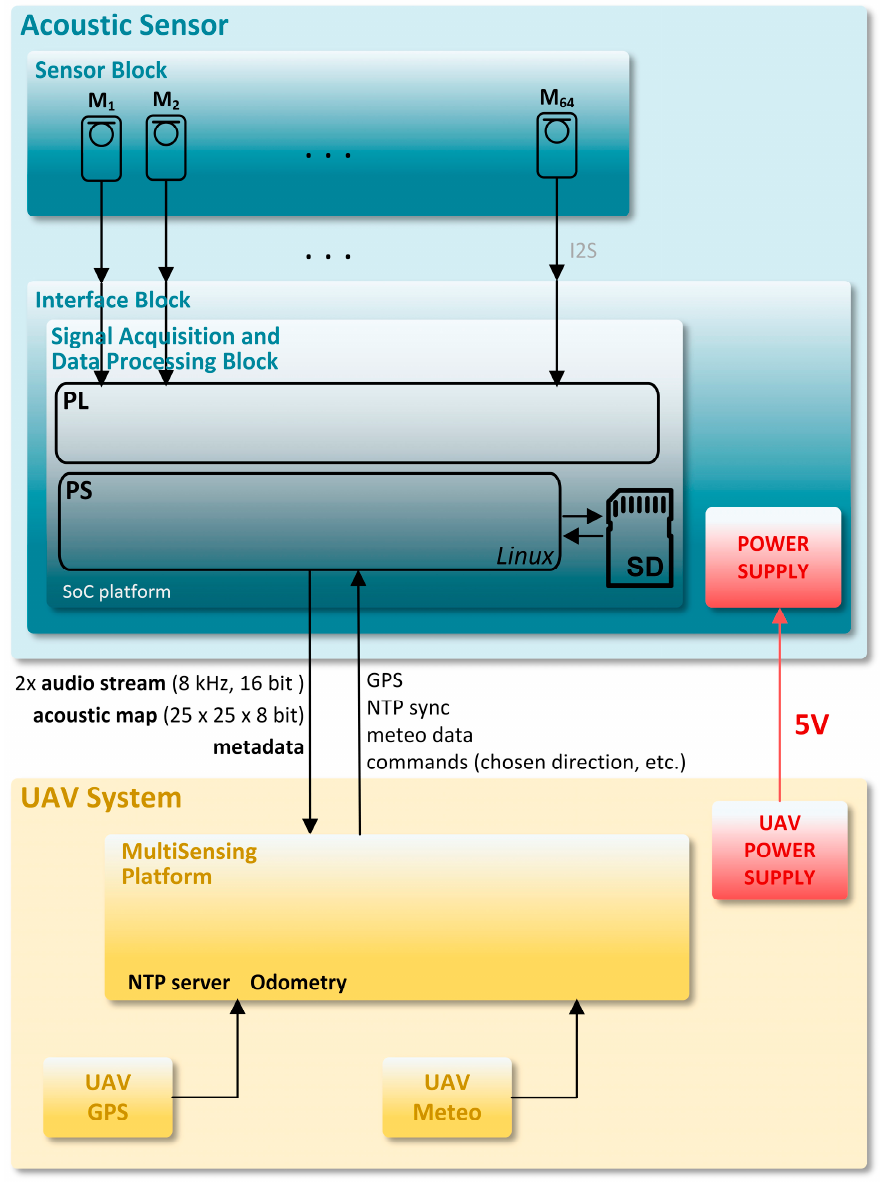
Figure 3. System architecture block diagram of the